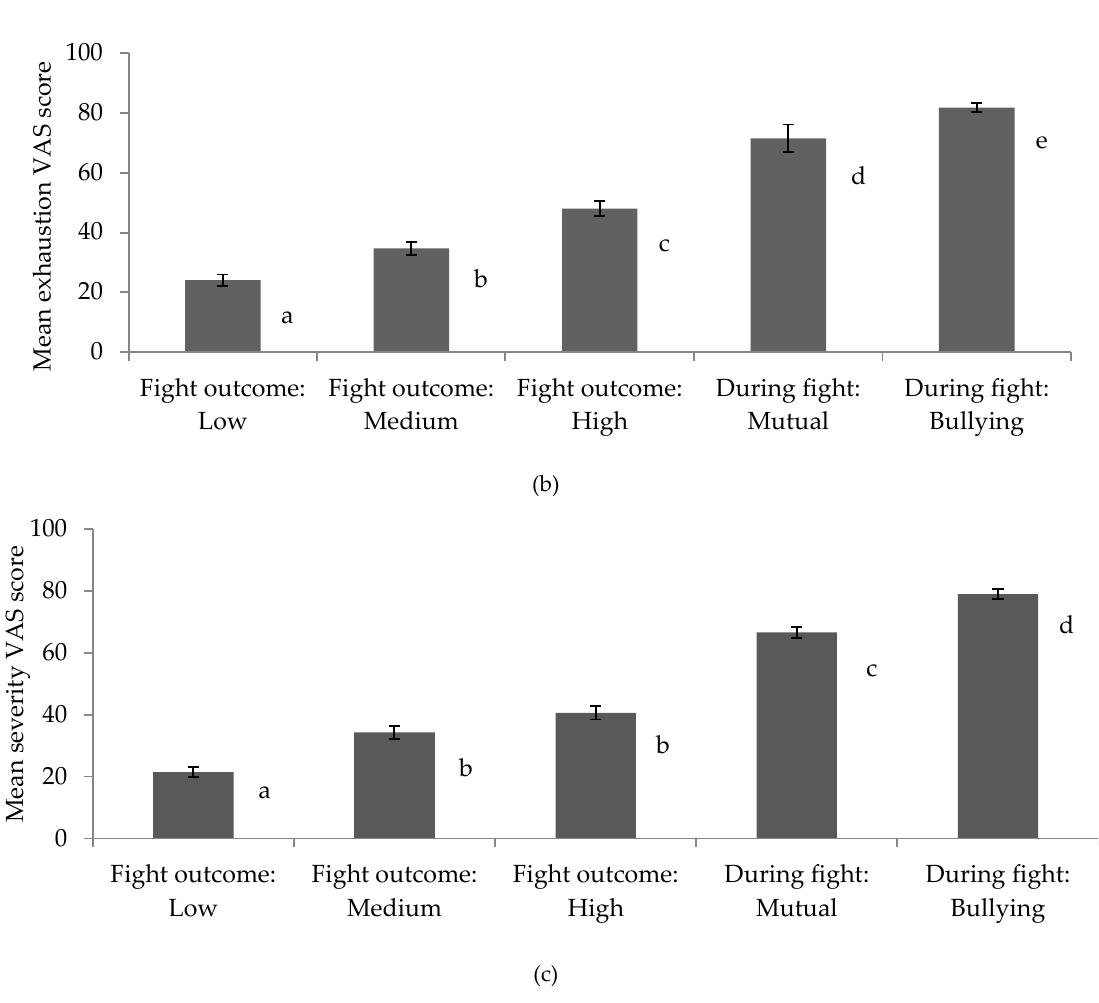
Figure 3. Mean visual analogue scale (VAS) score for ( a ) emotion, ( b ) exhaustion, and ( c ) severity according to video clip; whereby video clips with different letters express a significant difference in mean response.